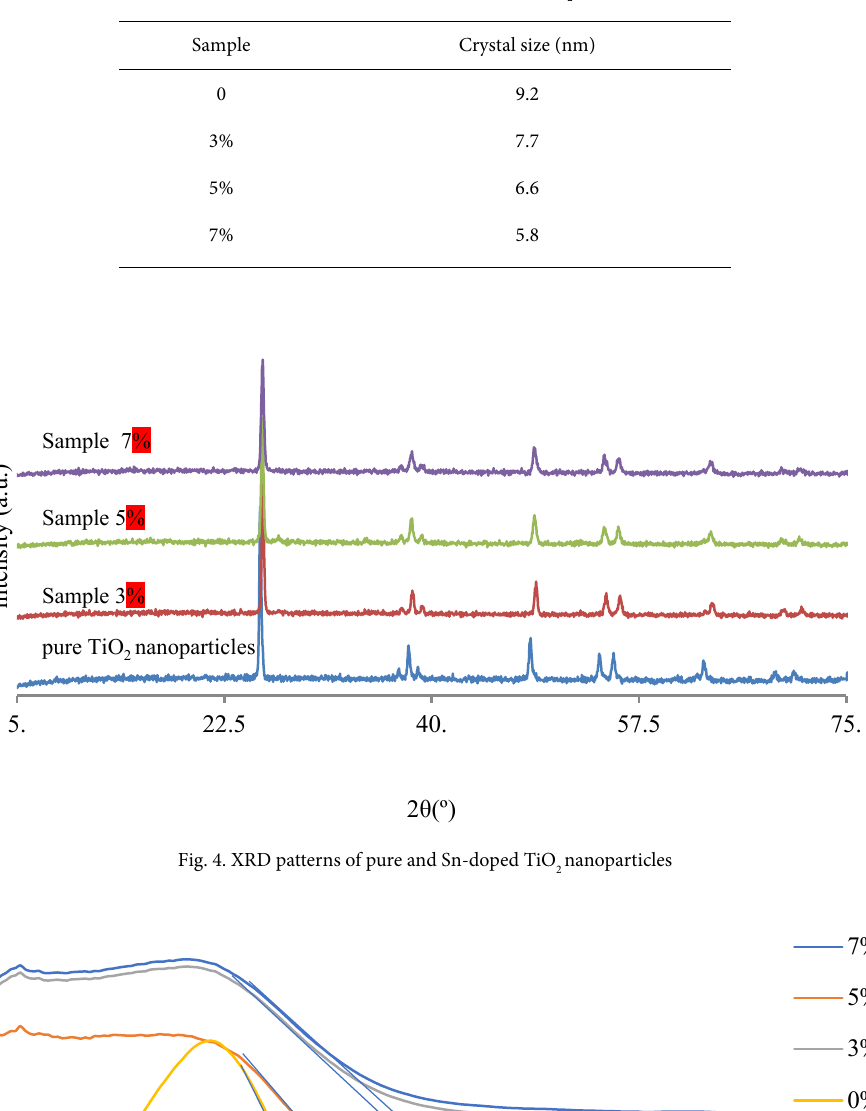
Table 2. Crystallite size of pure and Sn-doped TiO